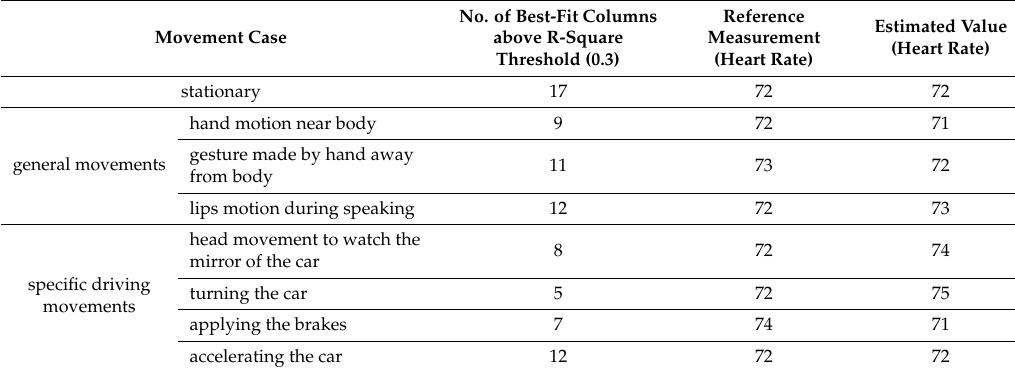
Table 2. Experimental results for heart rate measurements for different motion